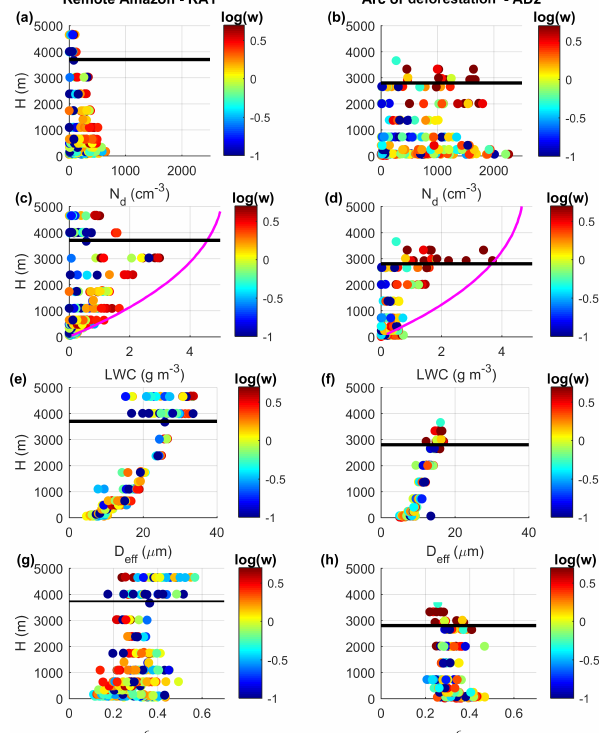
Figure 11. Vertical profiles of the 1Hz measurements of N d , LWC, D eff , and ε for background clouds over the remote Amazon (a, c, e, g) and polluted clouds over the arc of deforestation (b, d, f, h) . Updraft speeds are colored in log scale, corresponding to 0.1 ≤ w ≤ 5ms − 1 . Horizontal black lines mark the 0 ◦ C level. Ma- genta curves in (c) and (d) are the adiabatic water content profiles. H is relative to cloud base